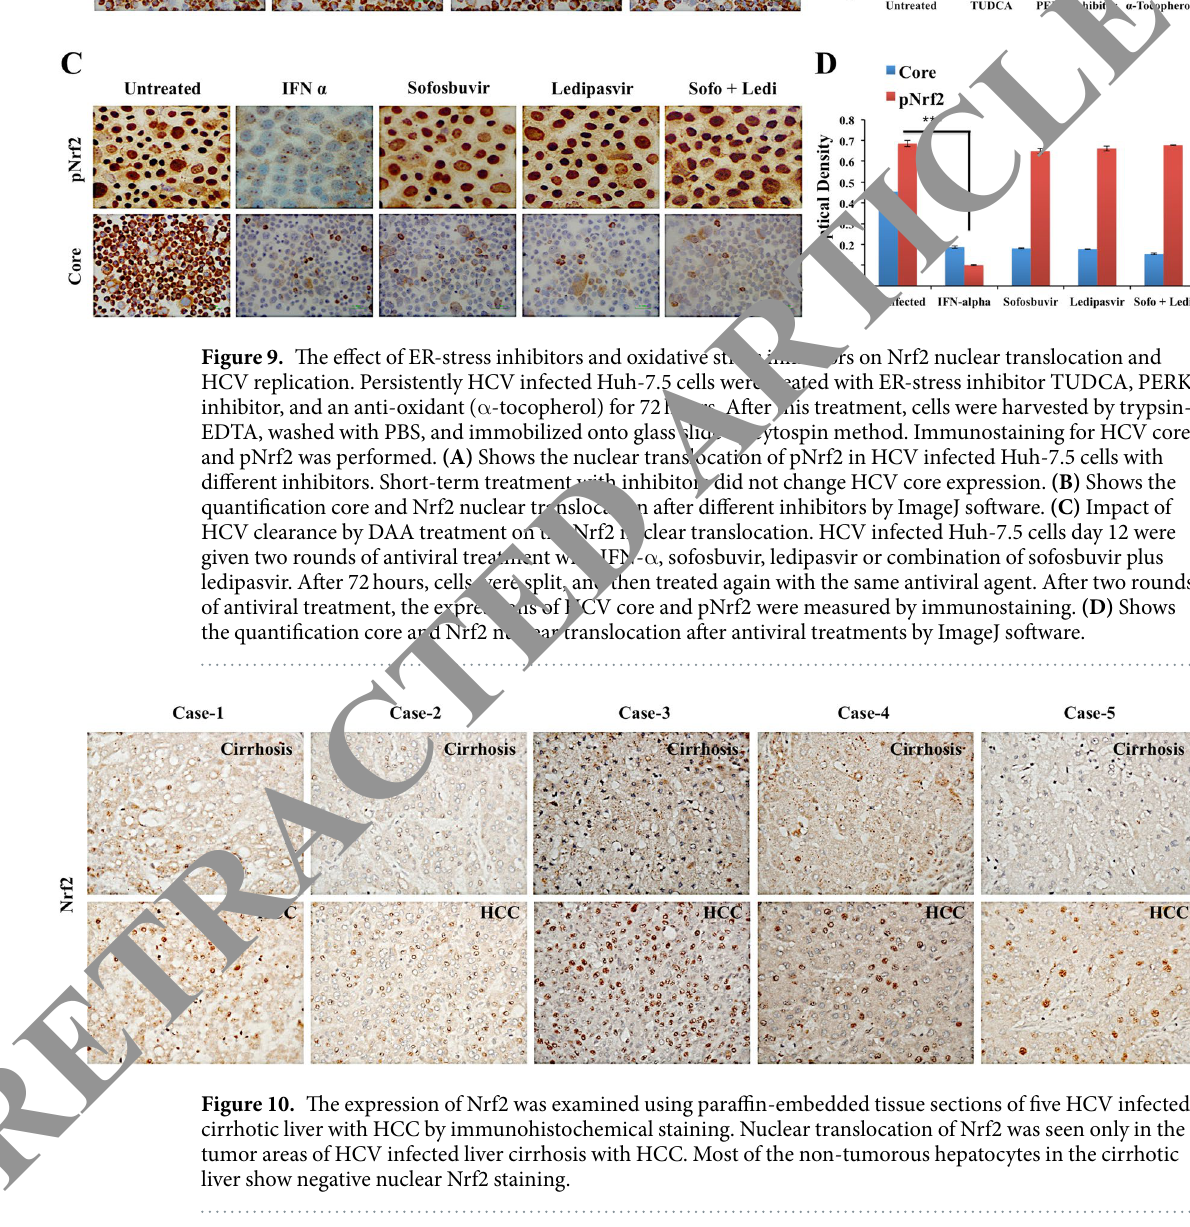
stress is not the main reason for nuclear translocation of Nrf2. We showed that silencing PERK pathway also inhibits Nrf2 activation in infected culture. To understand the significance of Nrf2 activation on HCV related cancer mechanisms, we examined Nrf2-mediated induction of Mdm2 and degradation of Rb tumor suppressor. Silencing Nrf2 pathway also inhib- ited Mdm2 expression and restored Rb degradation. This stress induced Nrf2 activation and Mdm2-mediated Rb degradation was verified using Huh-7.5 cells treated with ER-stress inducer. Both PERK inhibitor and TUDCA decreased Nrf2 nuclear translocation, inhibited Mdm2 levels and restored Rb degradation. Silencing